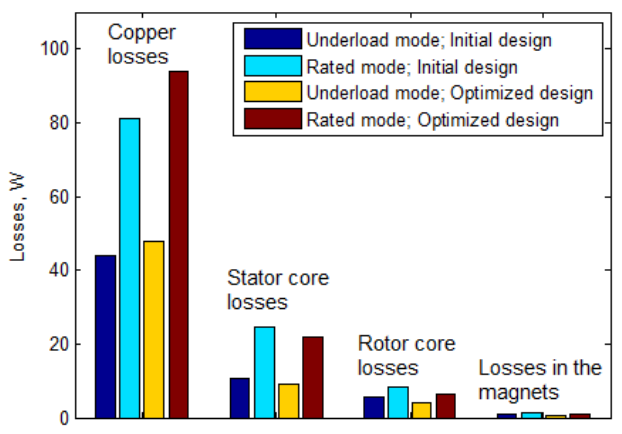
Figure 10. Losses for both FRMs in two modes.